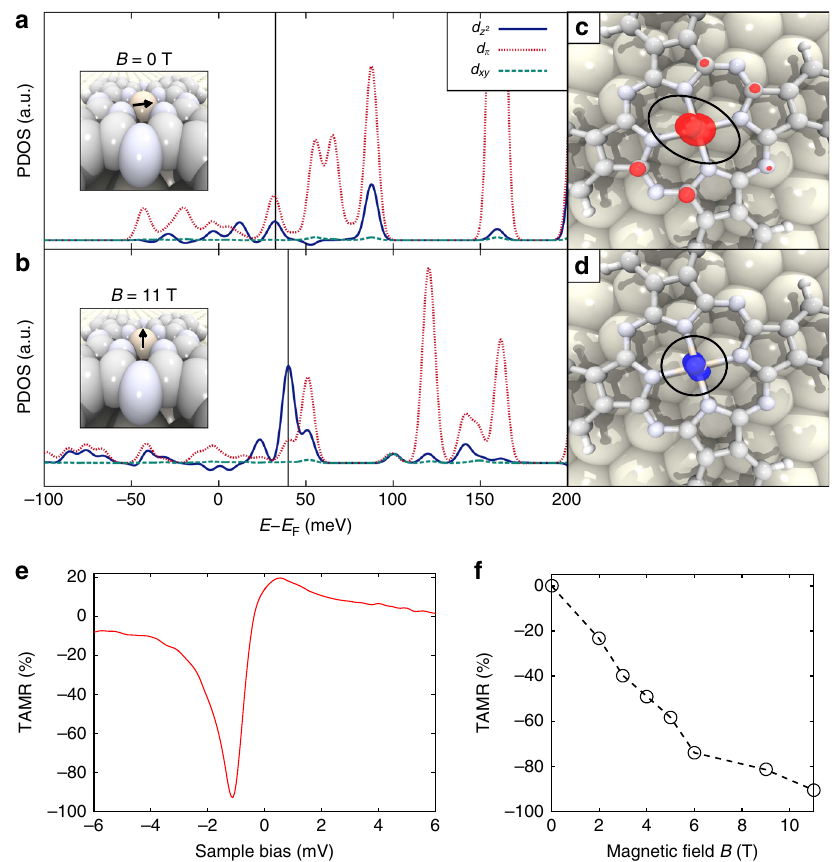
Fig. 4 Controlling the tunneling anisotropic magnetoresistance (TAMR). a and b Calculated lm -decomposed partial density of states (PDOS) of the d xy , d π , and d z 2 bands of the Fe atom with a magnetization vector in the plane of the molecule a and in the direction of the applied magnetic fi eld, perpendicular to the plane of the molecule b . The insets show the direction of the magnetic moment schematically. The energy is given with respect to E F . Black lines represent the energy of the molecular orbital closest to E F . c and d Band-decomposed charge density plots for the molecular orbitals close to E F , showing the similar spatial distribution of the Kondo resonance as in Fig. 3a, d. We note that the orbital density on the C atoms in c is unlikely to have a signi fi cant overlap with the substrate and thus will not contribute signi fi cantly to the signals in the d I /d V maps. e TAMR values at different bias voltages calculated from the d I /d V spectra taken on the Fe center at B = 0 and 11 T. f TAMR values at different magnetic fi eld calculated from the d I /d V spectra taken on the Fe center at the bias voltage of − 1.06 mV. a.u. arbitrary